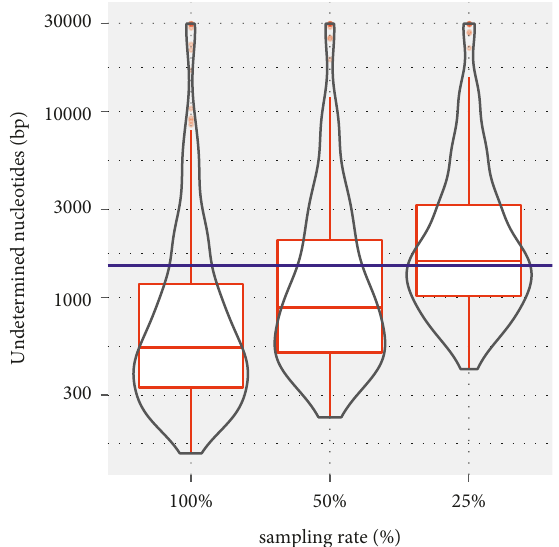
Figure 4: Distribution of undetermined nucleotides length in 304 clinical samples. Undetermined nucleotides with read depths less than five are analyzed using sequence reads from 25% downsampled, 50% downsampled, or whole-FASTQ data (100%) obtained from single MiSeq runs for the 304 samples. Distributions of the lengths of the undetermined nucleotides are shown in the violin plots, while the box plots show the 1 st quantile, median, and 3 rd quantile values. The blue line shows the threshold of 1495bp, which is 5% of the whole SARS-CoV-2 genome sequence.